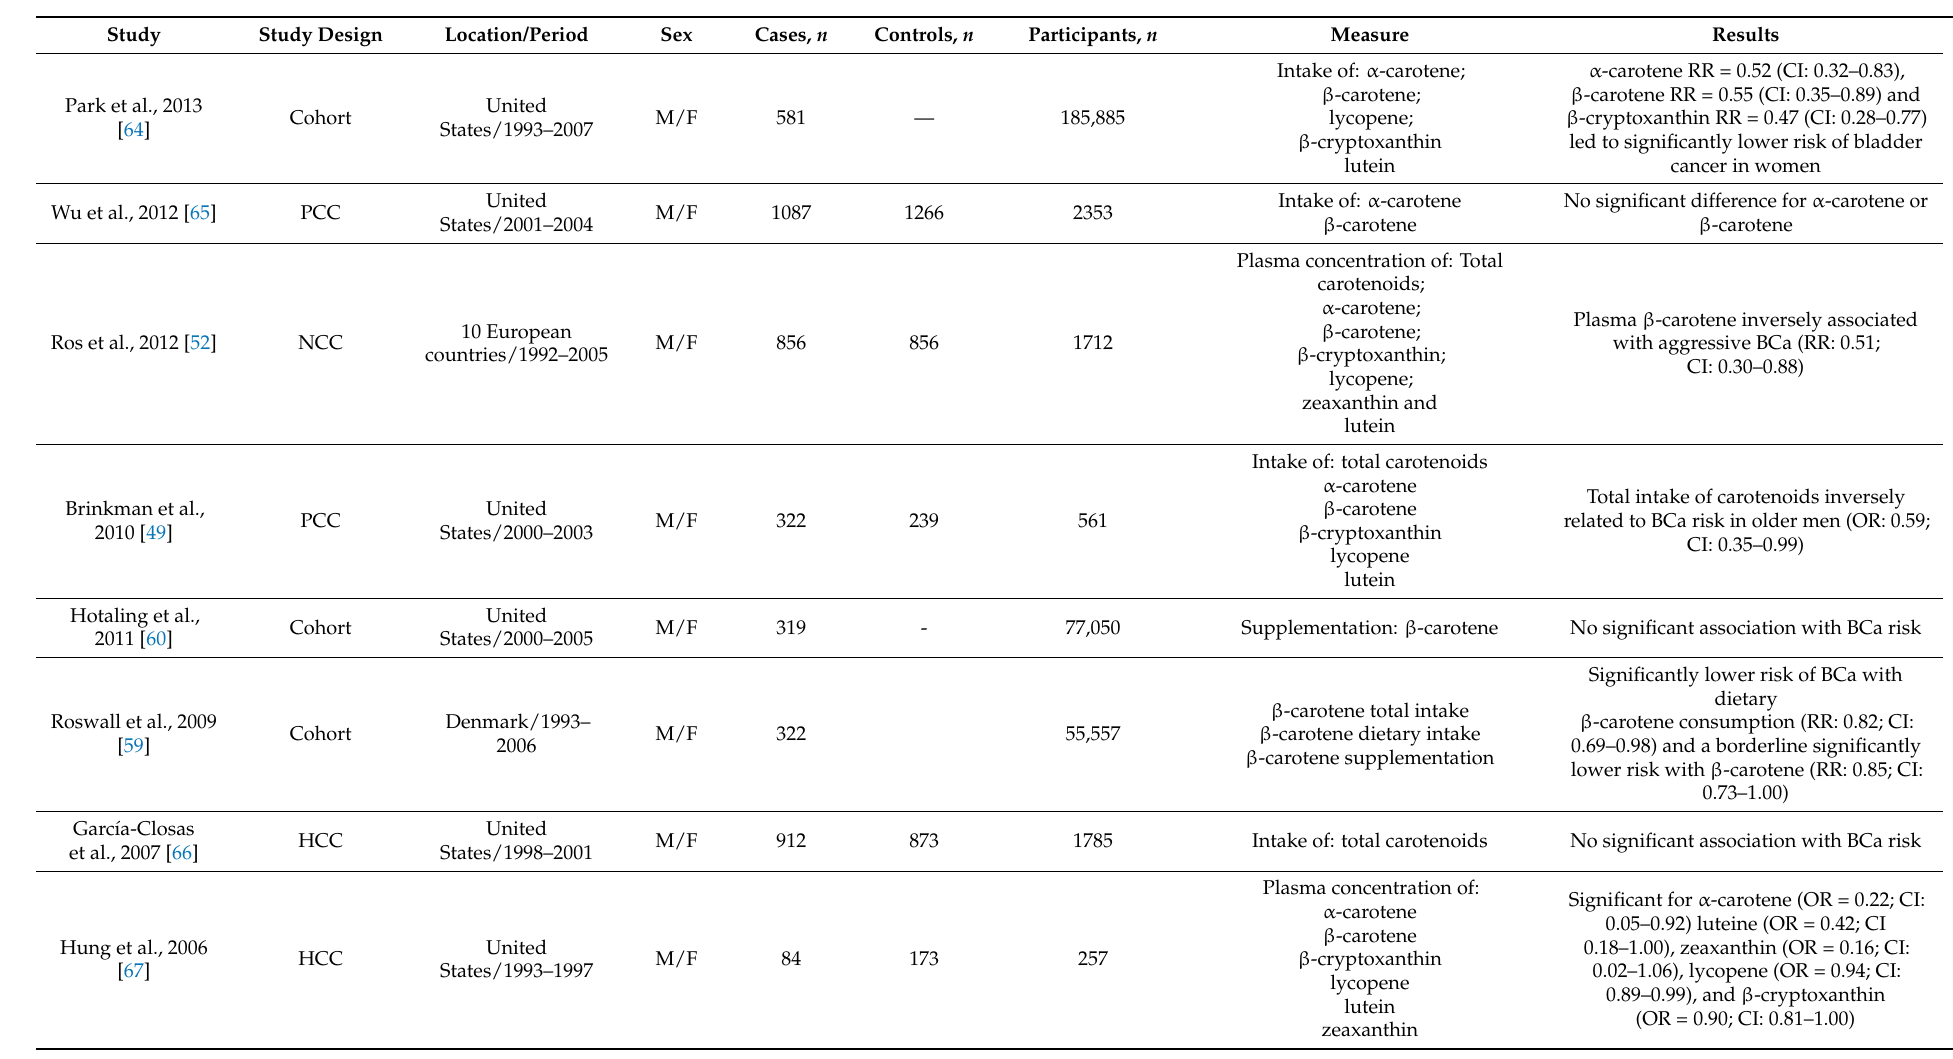
Table 2. Characteristics of epidemiological studies assessing carotenoids’ effect on bladder cancer